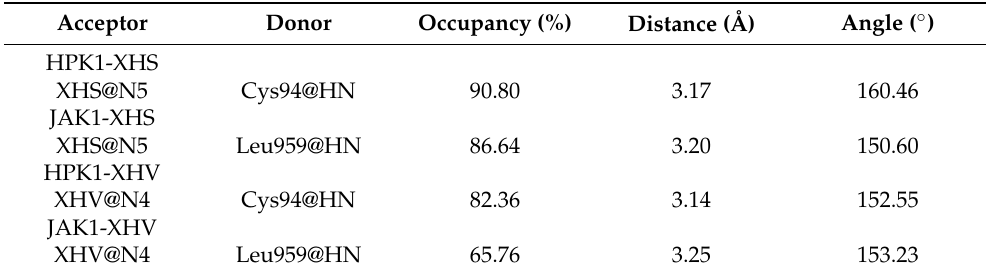
Table 2. Hydrogen bond interaction between the inhibitors and kinases HPK1/JAK1.